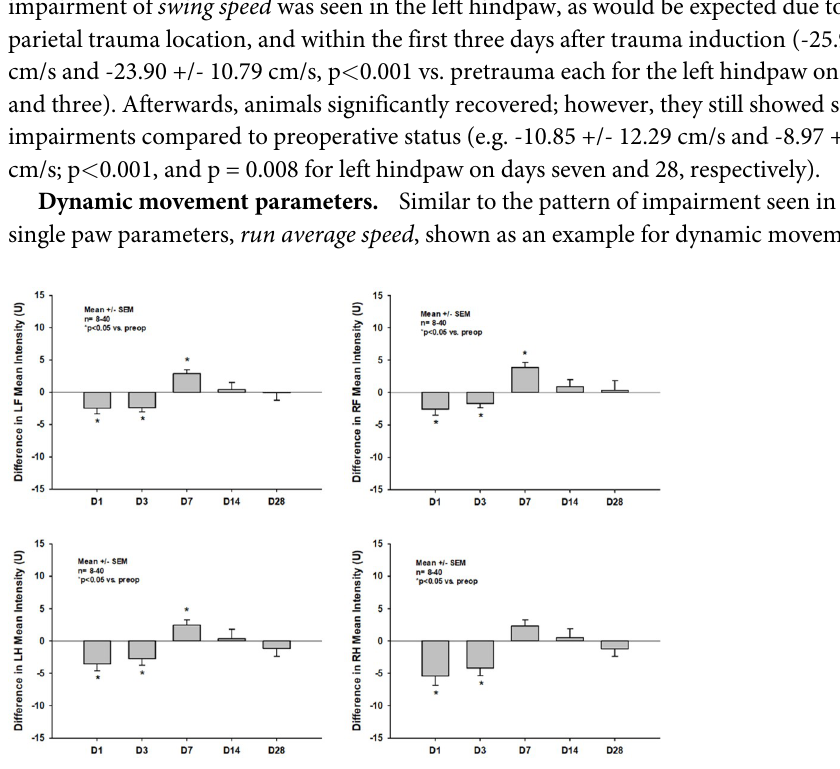
Fig 5. Differences in mean intensity of the four single paws compared to pretrauma status on days one thru 28 after CCI.